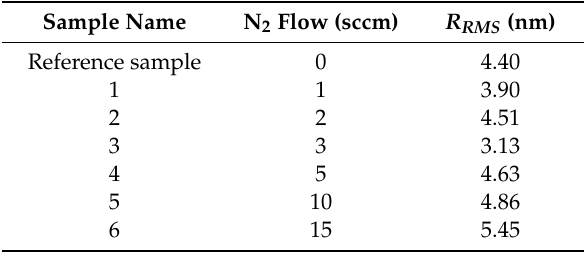
Figure 3. AFM images (1 µm × 1 µm size) for ( a ) the reference sample, ( b ) Sample 4, ( c ) Sample 5 and ( d ) Sample 6. Table 2. N:Cu 2 O thin film samples and corresponding root-mean square surface roughness ( R RMS ) extracted from recorded AFM images.